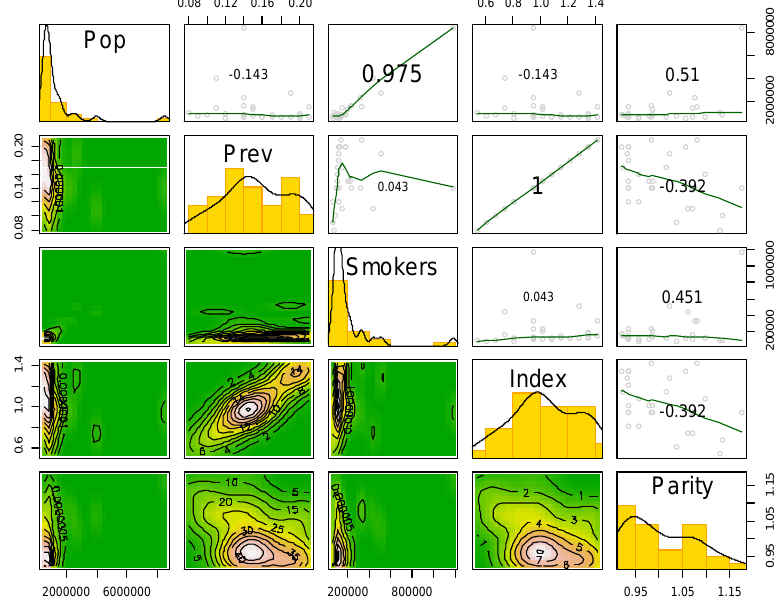
Figure 2. Scatterplot matrix of variables used in the simulation model for estimating the costs of